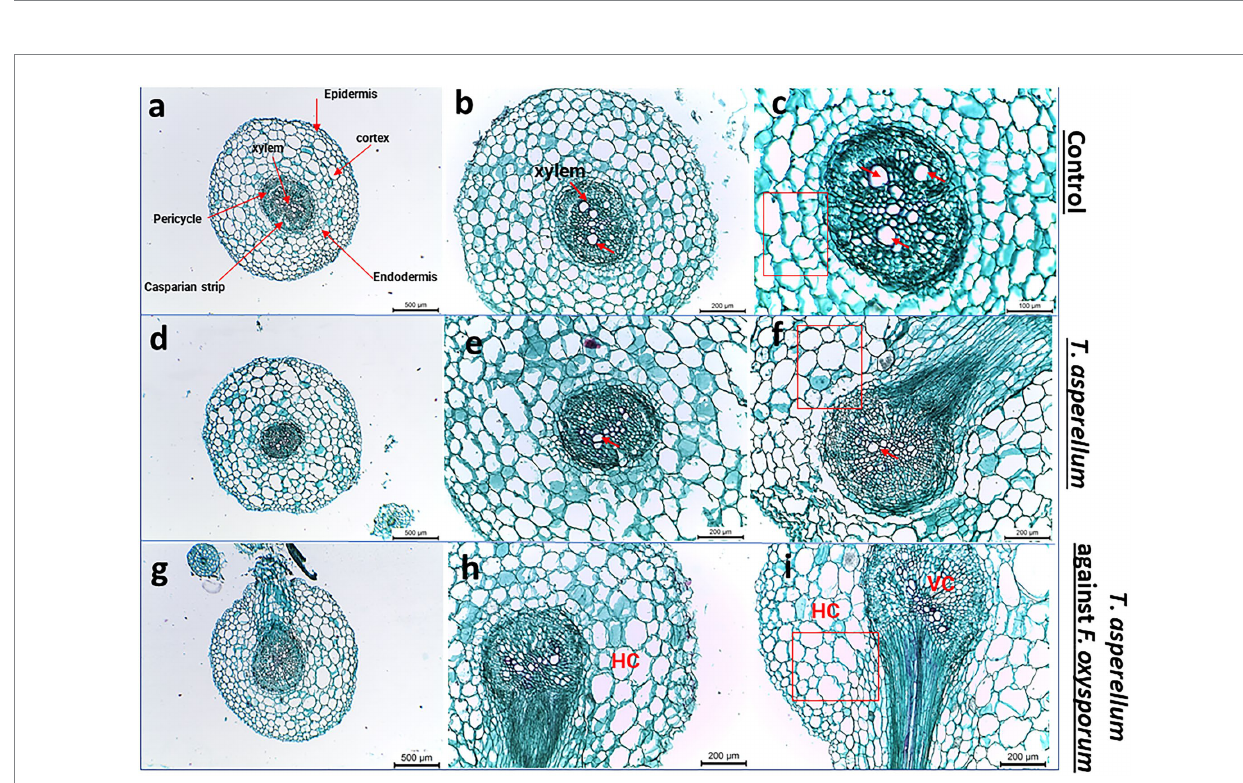
FIGURE 7 Light microscope images of tomato root cross sections near the root tip taken from plants grown under biotic stress. (A–C) Healthy tomato root, (D–F) Transverse sections of tomato roots plant treated with Trichoderma , (G–I) shows the root cross-sections after applying Trichoderma against Fusarium pathogen. Red arrows indicate the xylem